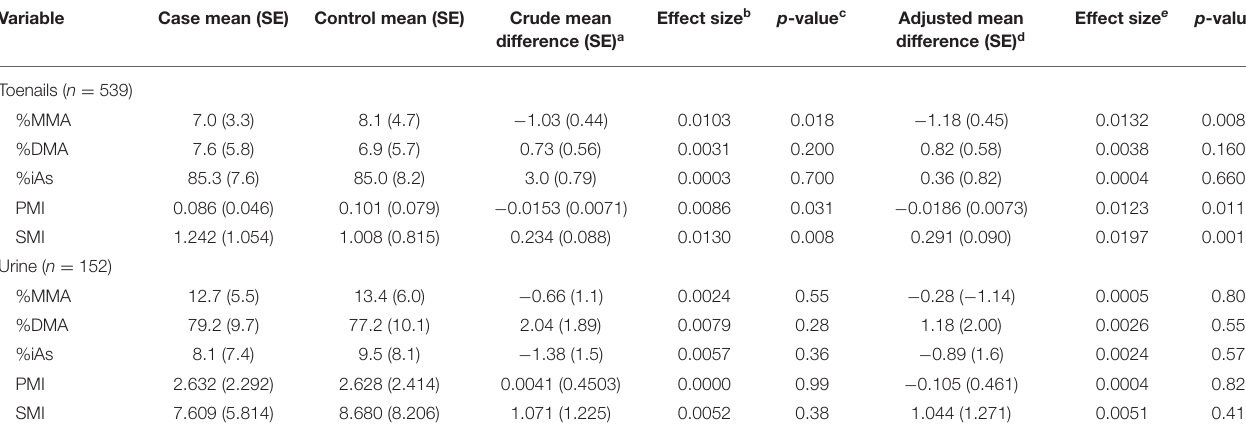
TABLE 2 | ANOVA (crude) and ANCOVA (adjusted) models of arsenic speciation measures in toenail and urine samples between prostate cancer cases and controls. Variable Case mean (SE) Control mean (SE) Crude mean